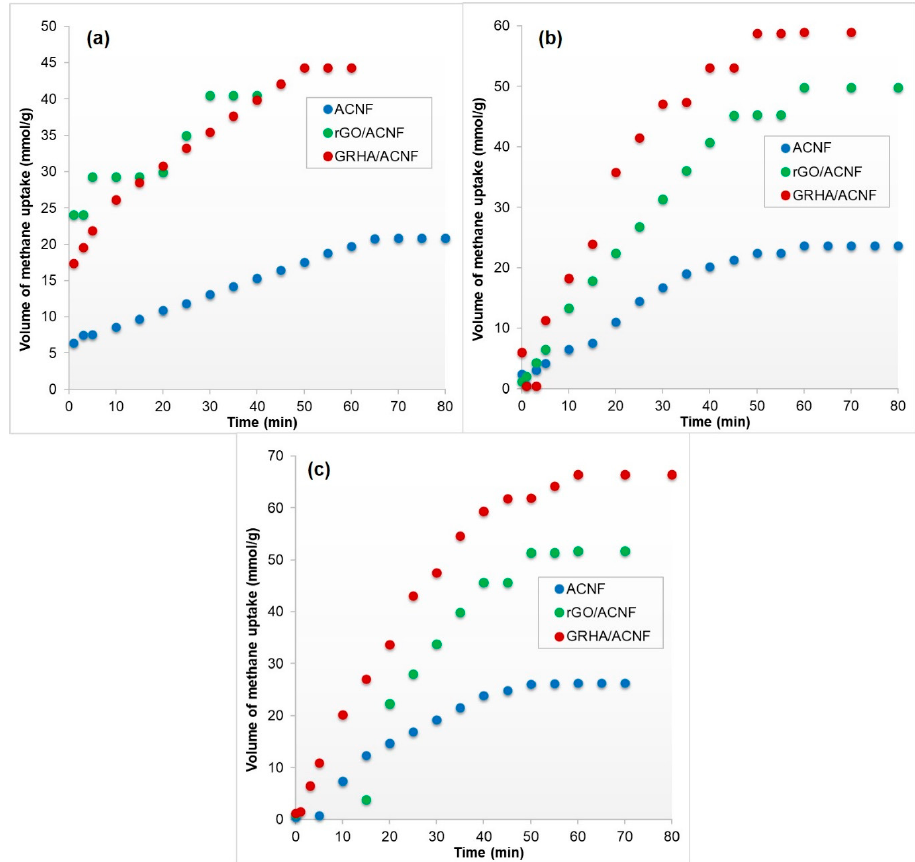
Figure 8. Adsorption profile of methane to reach equilibrium on the ACNF, rGO/ACNF, and GRHA/ACNF at different pressures: ( a ) 4 bar, ( b ) 8 bar, and ( c ) 12 bar. ACNF: activated carbon nanofibers, rGO: ACNF: activated carbon nanofibers, GRHA: graphene-derived rice husk ashes. Table 3. Comparison of methane adsorption capacity on various activated carbon fibers and their composite-based